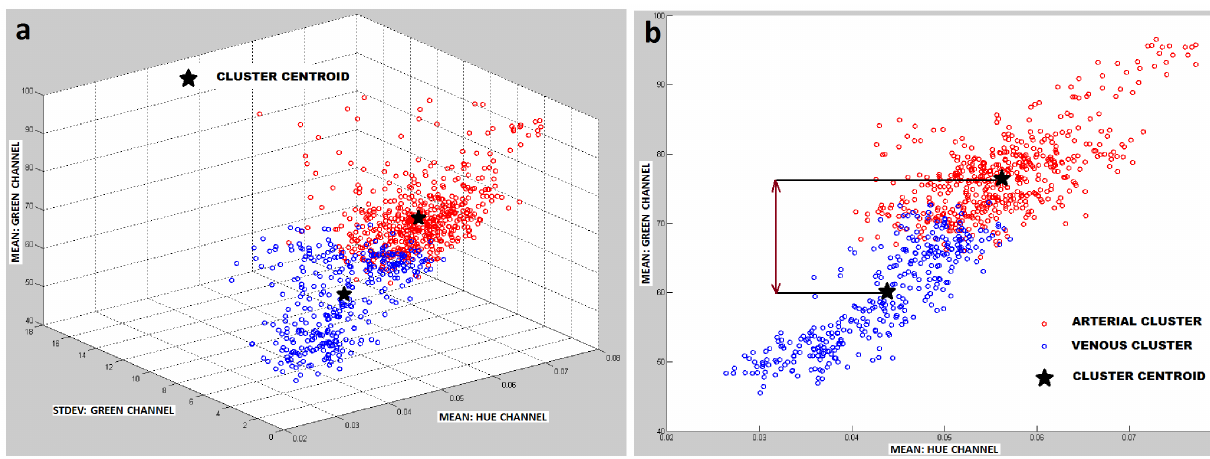
Figure 9. Fuzzy C-means clustering: a) Cluster formation b) Comparison of mean green channel intensity. with MG represented on Y-axis. The cluster with higher average value of mean green channel intensity ( MG mean ) is labeled as arterial cluster and the other cluster as the venous cluster, since arteries appear brighter relative to veins.